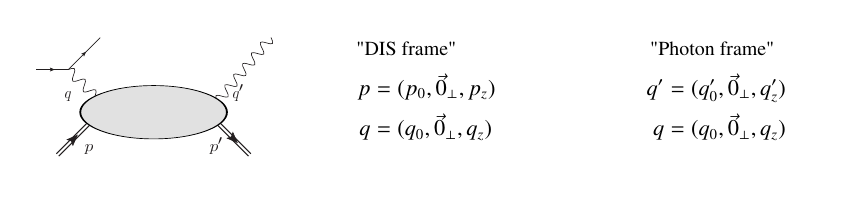
Figure 5. Two examples of possible choices of longitudinal and transverse directions in DVCS